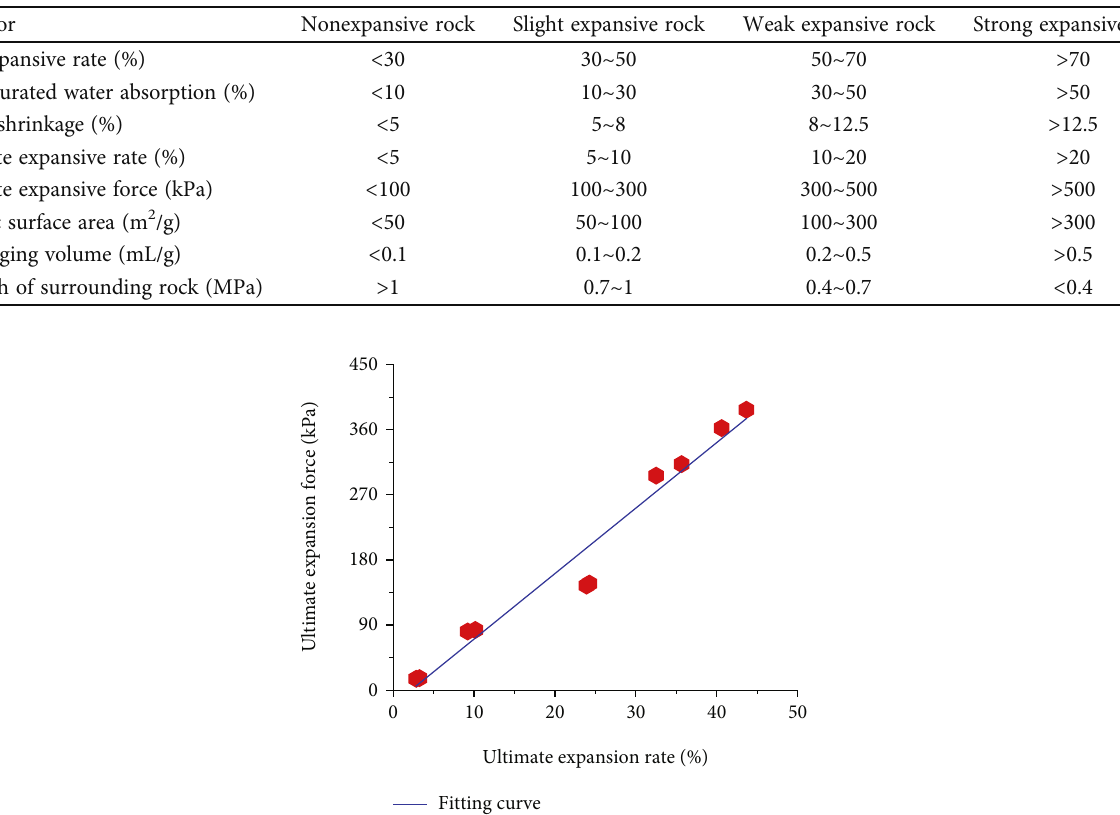
Table 7: Main classi fi cation standards of expansive rock [13, 14, 18, 39].